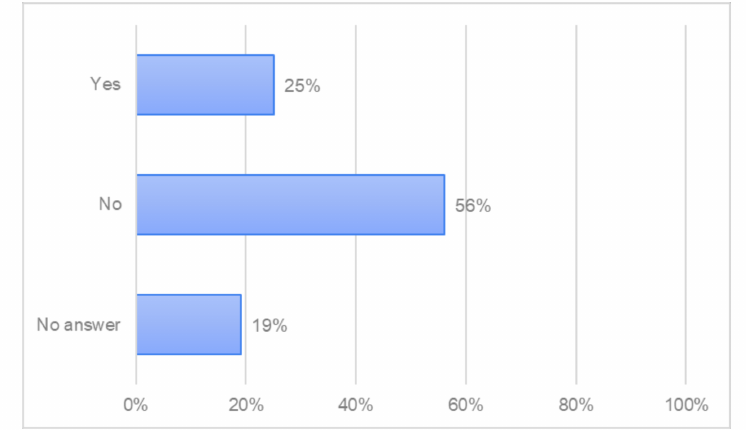
Figure 5. Summary of injuries at gradual